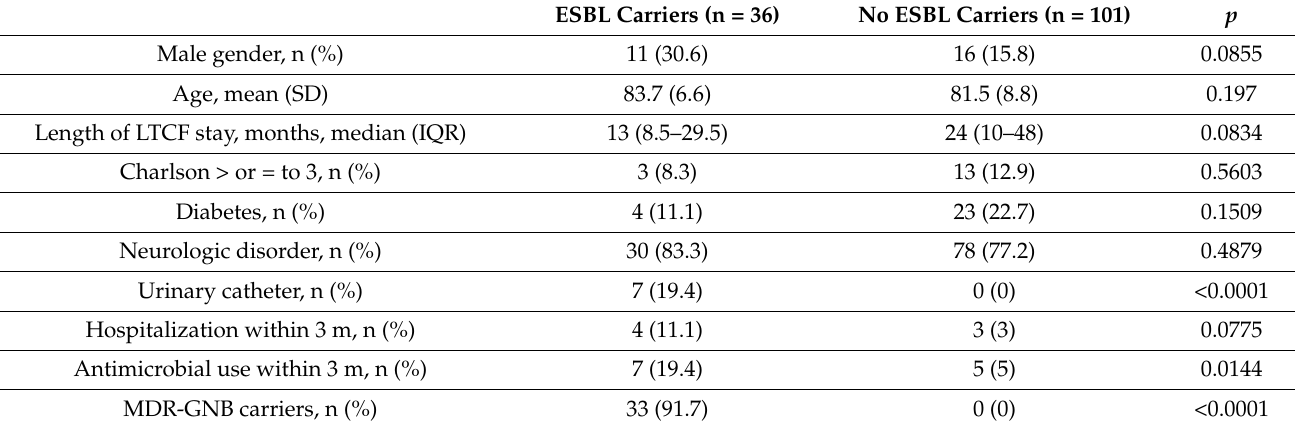
Table 5. Characteristics of LTCF residents regarding colonization by ESBL-producing